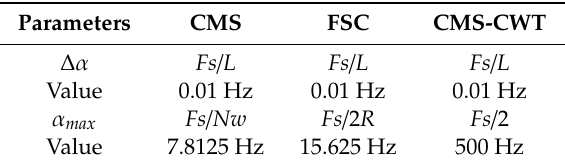
Table 1. Parameters setting.